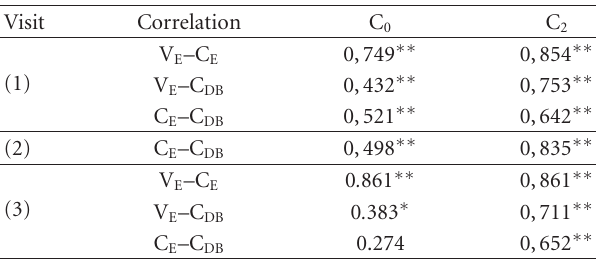
Table 1: Correlations of venous and capillary CsA concentrations. Table 2: Absolute mean venous and capillary CsA concentrations of all patients at all